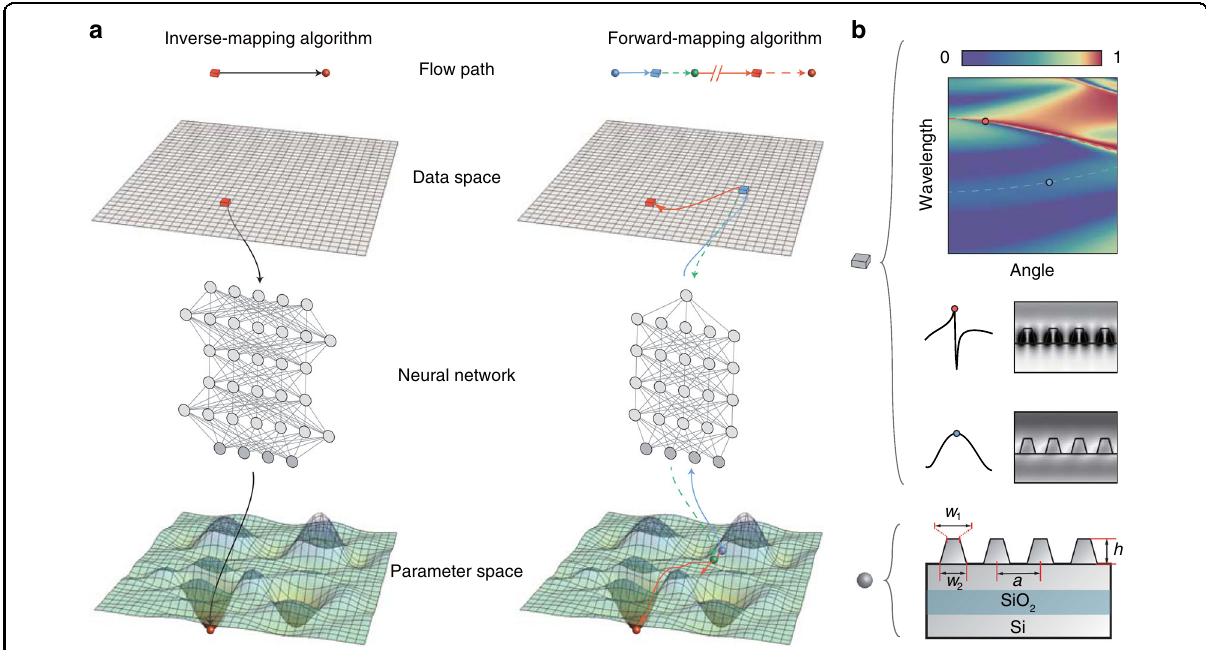
Fig. 1 Two NN-based algorithms for solving ISPs. a Schematic overview of the solving process of two NN-based algorithms. The top space is the data space; the bottom space is the parameter space. The arrows are fl ow paths to describe the steps of algorithms. The fl uctuations in parameter space stand for the difference between the detected response and theoretical response at a local point. b Upper panel: Each representative point (block) in the data space stands for a theoretical dispersion corresponding to the parameter space. The corresponding electric fi eld distributions of the points in the dispersion are shown together with their angle-resolved spectra. Lower panel: Each representative point (ball) in the parameter space stands for a group of geometric parameters and components. The grating structure is modeled using four parameters: top line width w 1 , bottom line width w 2 , pitch a and height